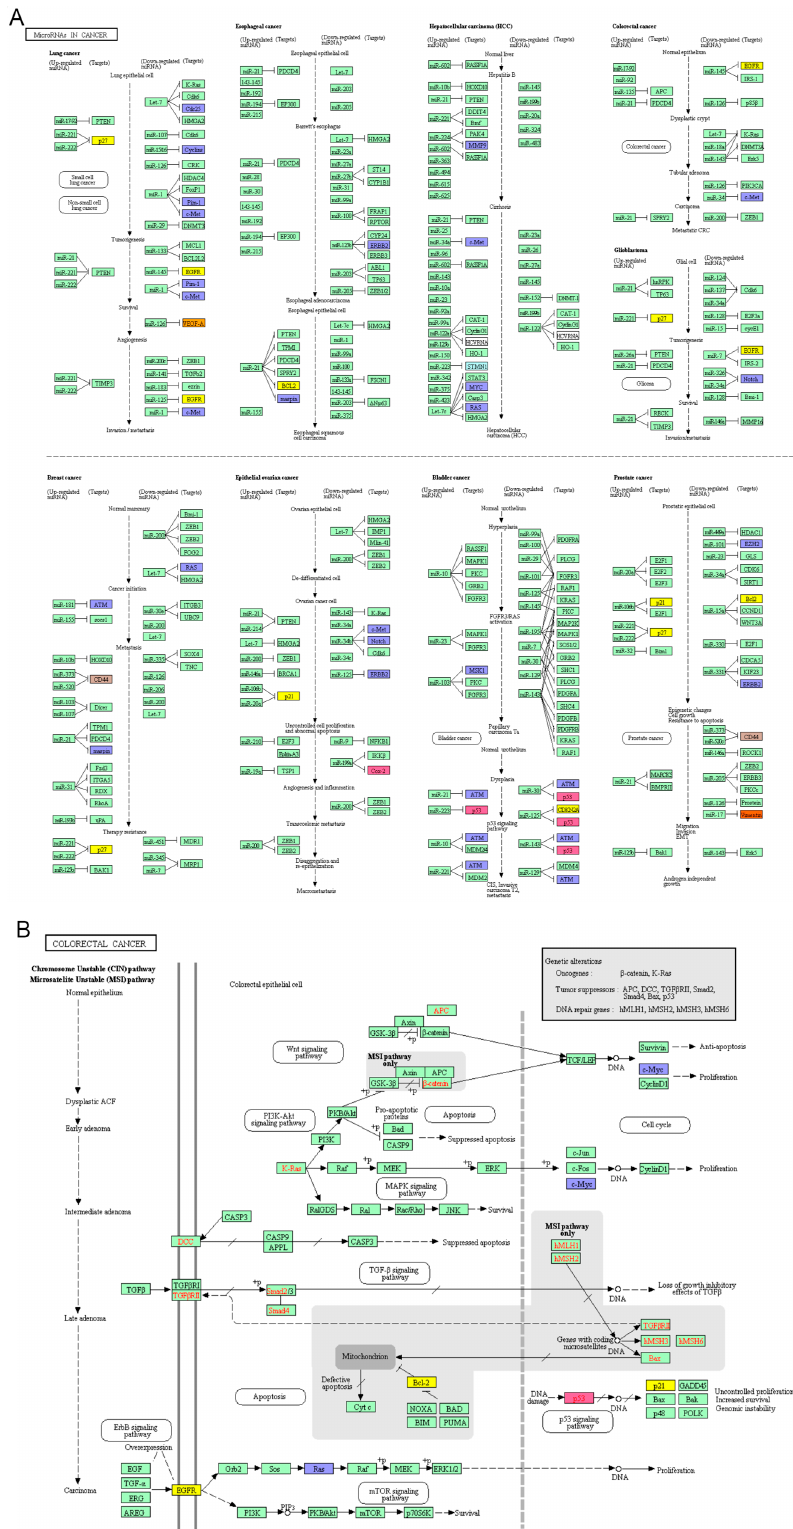
Figure 4. MiRNA in cancers. ( A ) MiRNAs involve in different types of cancers. ( B ) CRC Biomarkers in the miRNAs in cancer pathway. Different miRNAs and interactions among the miRNAs and a variety of genes, such as APC and K-ras have been involved in CRC initiation and progression process.